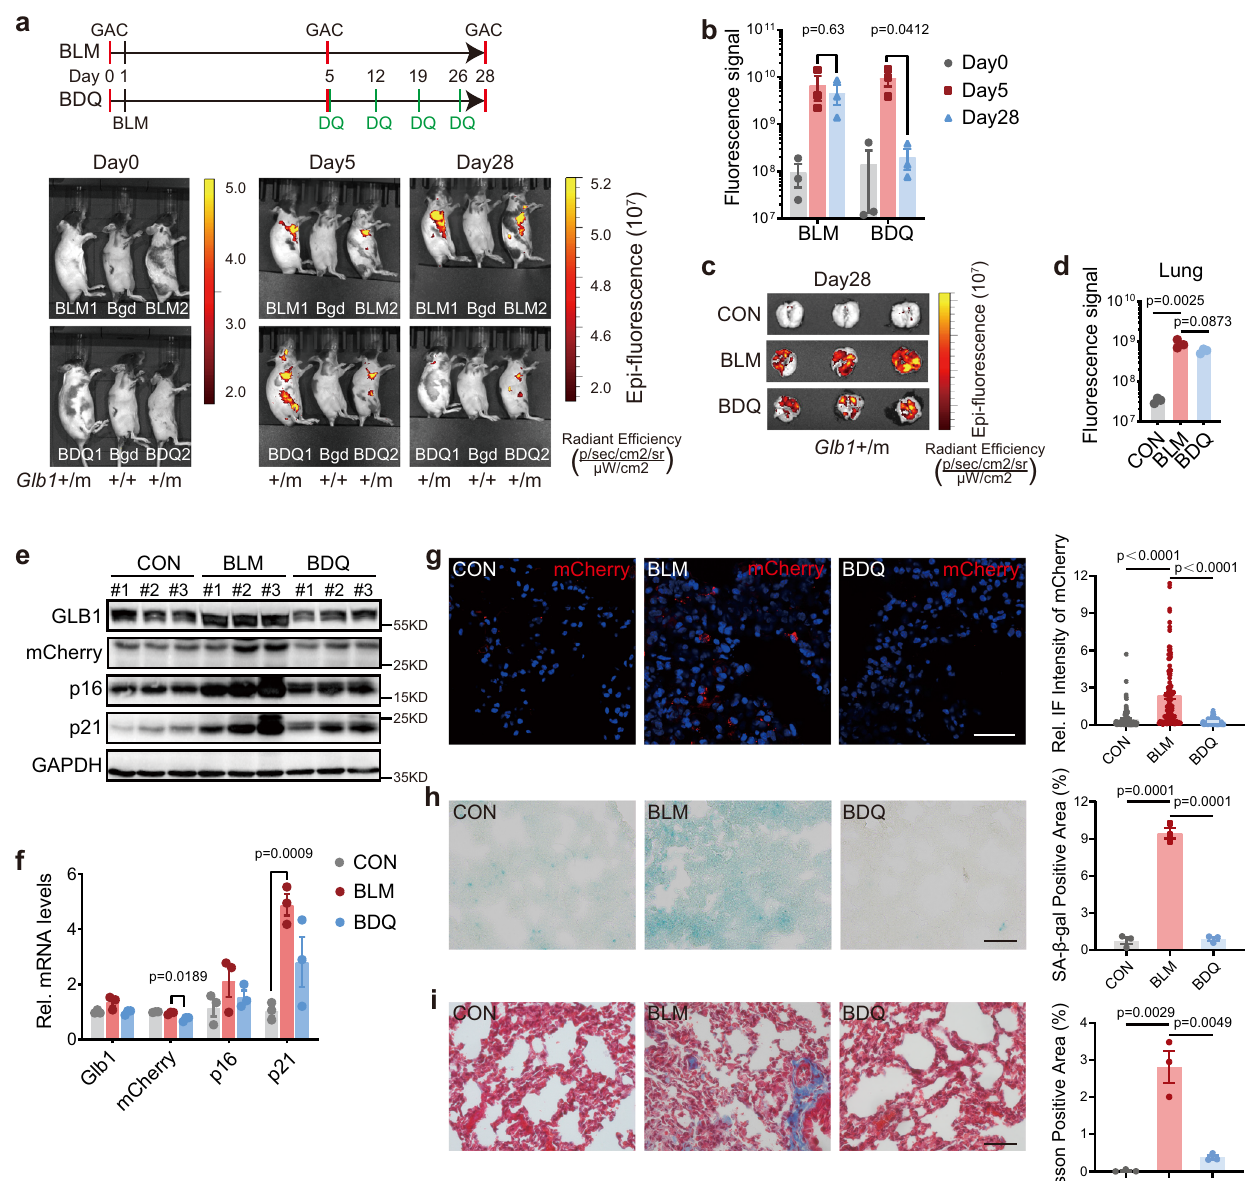
Fig. 7 | Senolytic therapies attenuate GAC signal in Glb1 +/m mice. Upper, the timeline of BLM treatment, BLM+D+Q treatment (BDQ) and GACimaging; lower, representative images ( a ) and quanti fi cation ( b ) of the GAC signal in lung anato- mical location from BLM (4 months, female, n =3) and BDQ (4 months, female, n =3)treated Glb1 +/m mice.4monthsfemale Glb1 +/+ mousewasusedforbackground (Bdg) fl uorescencesubtraction.Representativeimages( c )andquanti fi cationofthe GACsignal ( d ) in lung tissues from CON(4 months, female, n =3), BLM (4 months, female, n =3) and BDQ (4 months, female, n =3) Glb1 +/m mice on day 28 of the